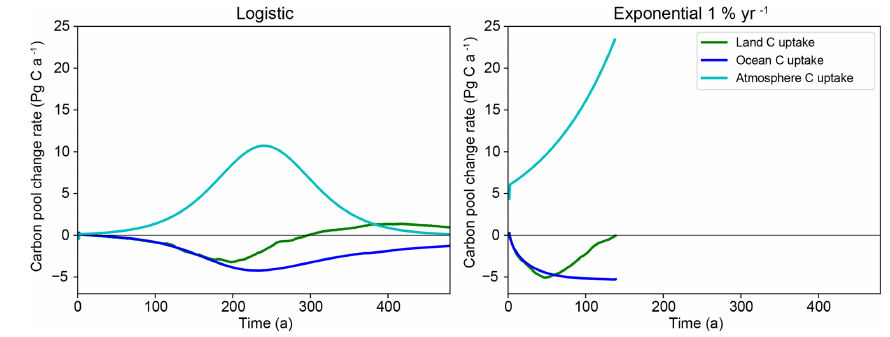
Figure 7. Uptake of carbon by the atmosphere, oceans and land systems in the logistic and 1% experiments.